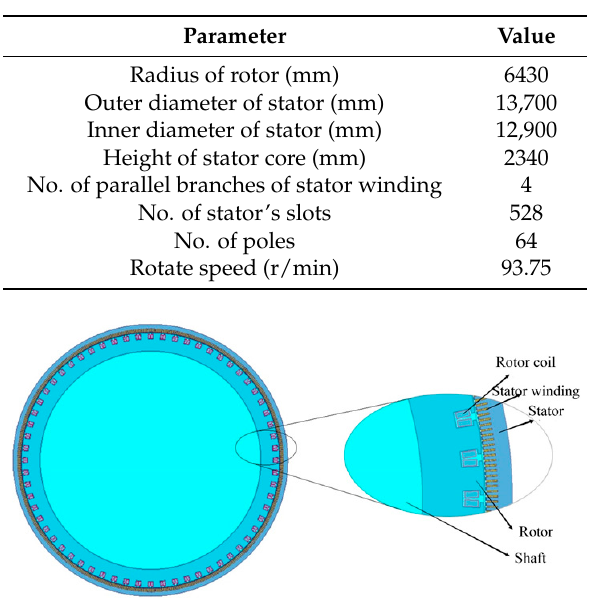
Table 1. Basic parameters of the electromagnetic model.